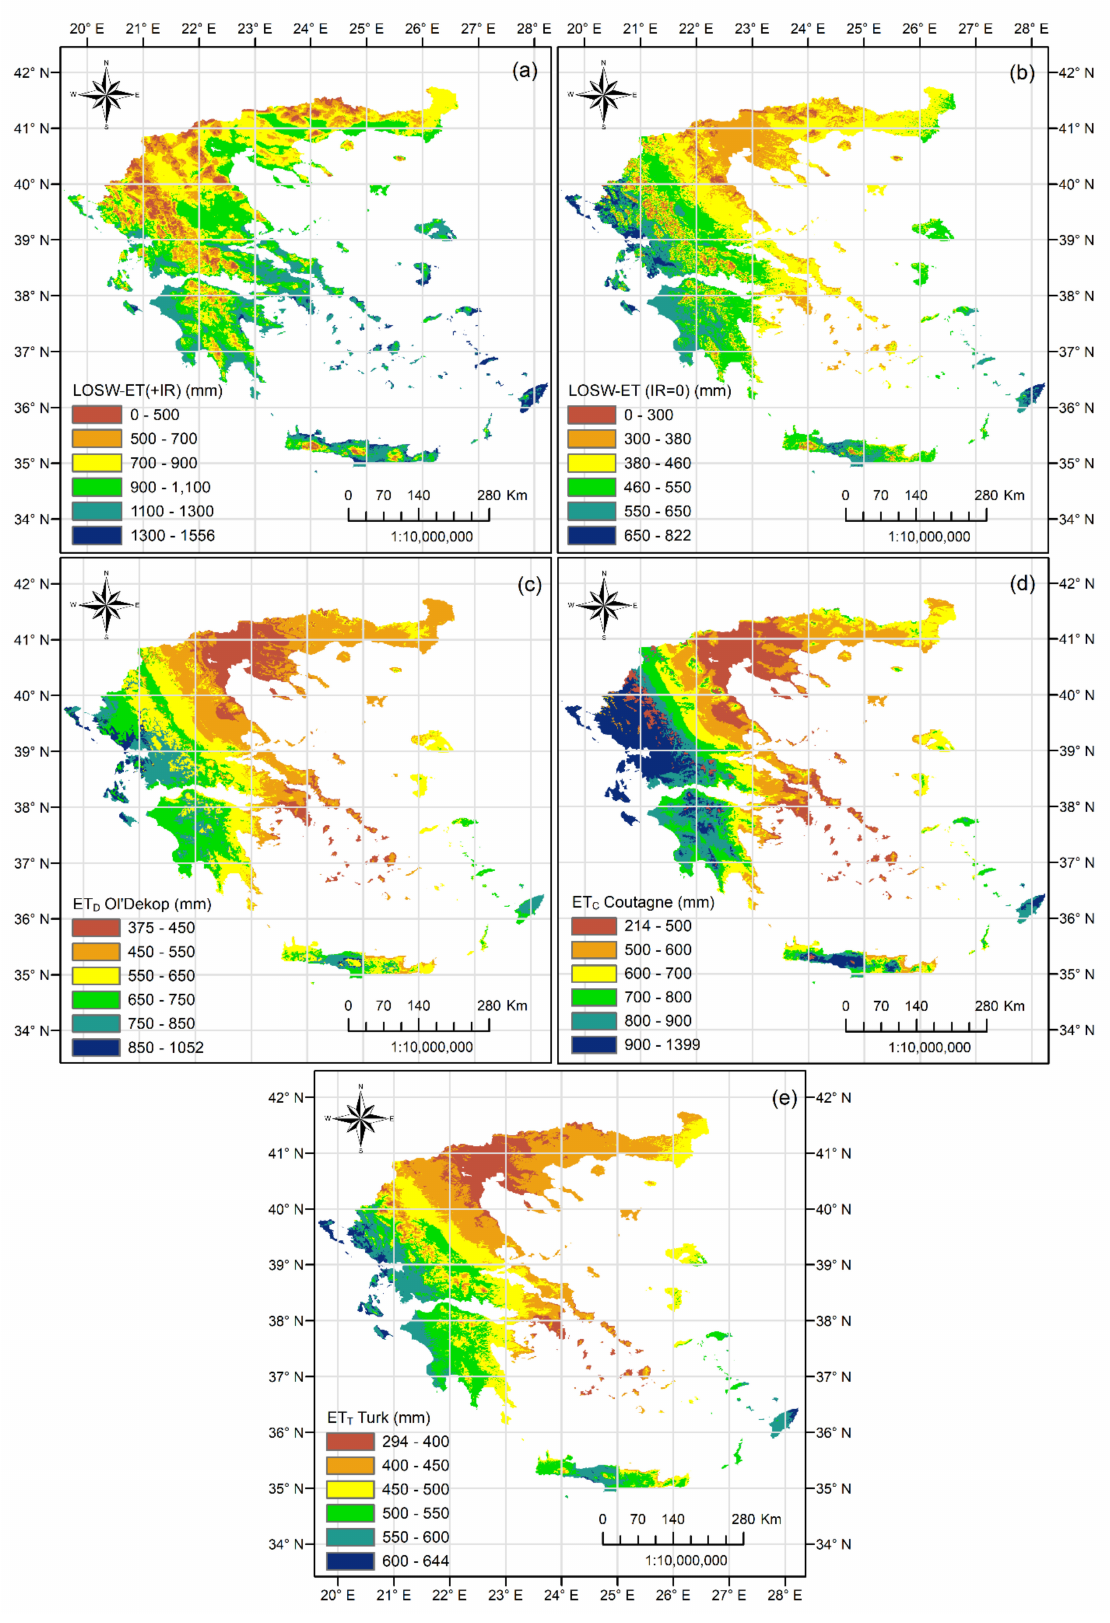
Figure 3. Mean annual actual evapotranspiration of ( a ) LOSW-ET with IR (cid:54) = 0, ( b ) LOSW-ET with IR = 0, ( c ) ET D Oldekop, ( d ) ET C Coutagne and ( e ) ET T Turk for the period